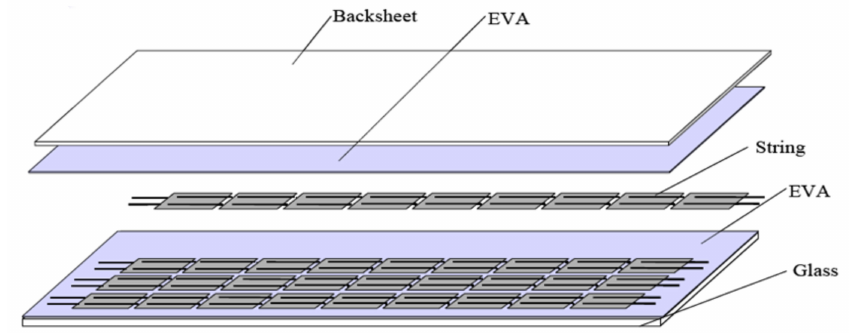
Figure 4. The PV module packaging structure.